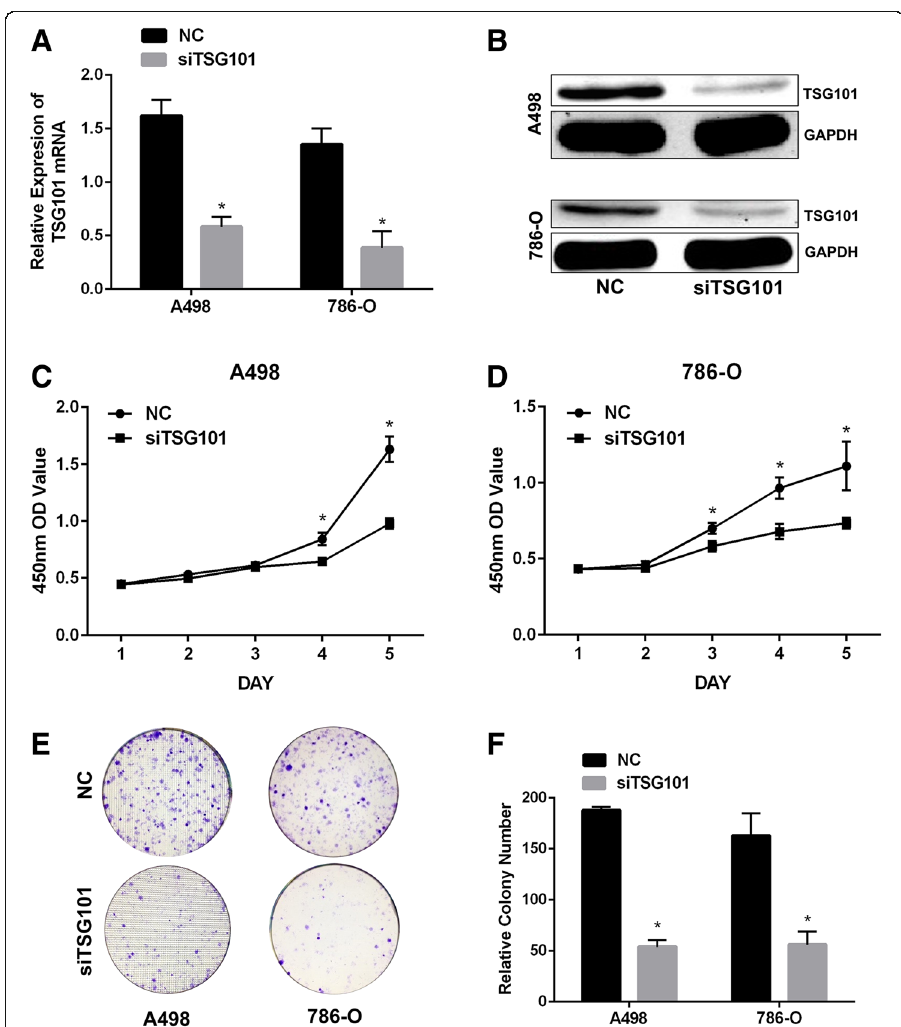
Fig. 2 Knockdown of TSG101 inhibited cell proliferation and colony formation ability in RCC. a qRT-PCR and ( b ) western blot confirmed that TSG101 could be silenced successfully by siRNA. CCK-8 assays of ( c ) A498 and ( d ) 786-O cells transfected with siTSG101 or NC. e and f Colony formation assays of A498 and 786-O cells transfected with siTSG101 or NC. Representative images and average colony numbers are shown. Data are presented as means ± SD. * p < 0.05 vs. NC ( n =